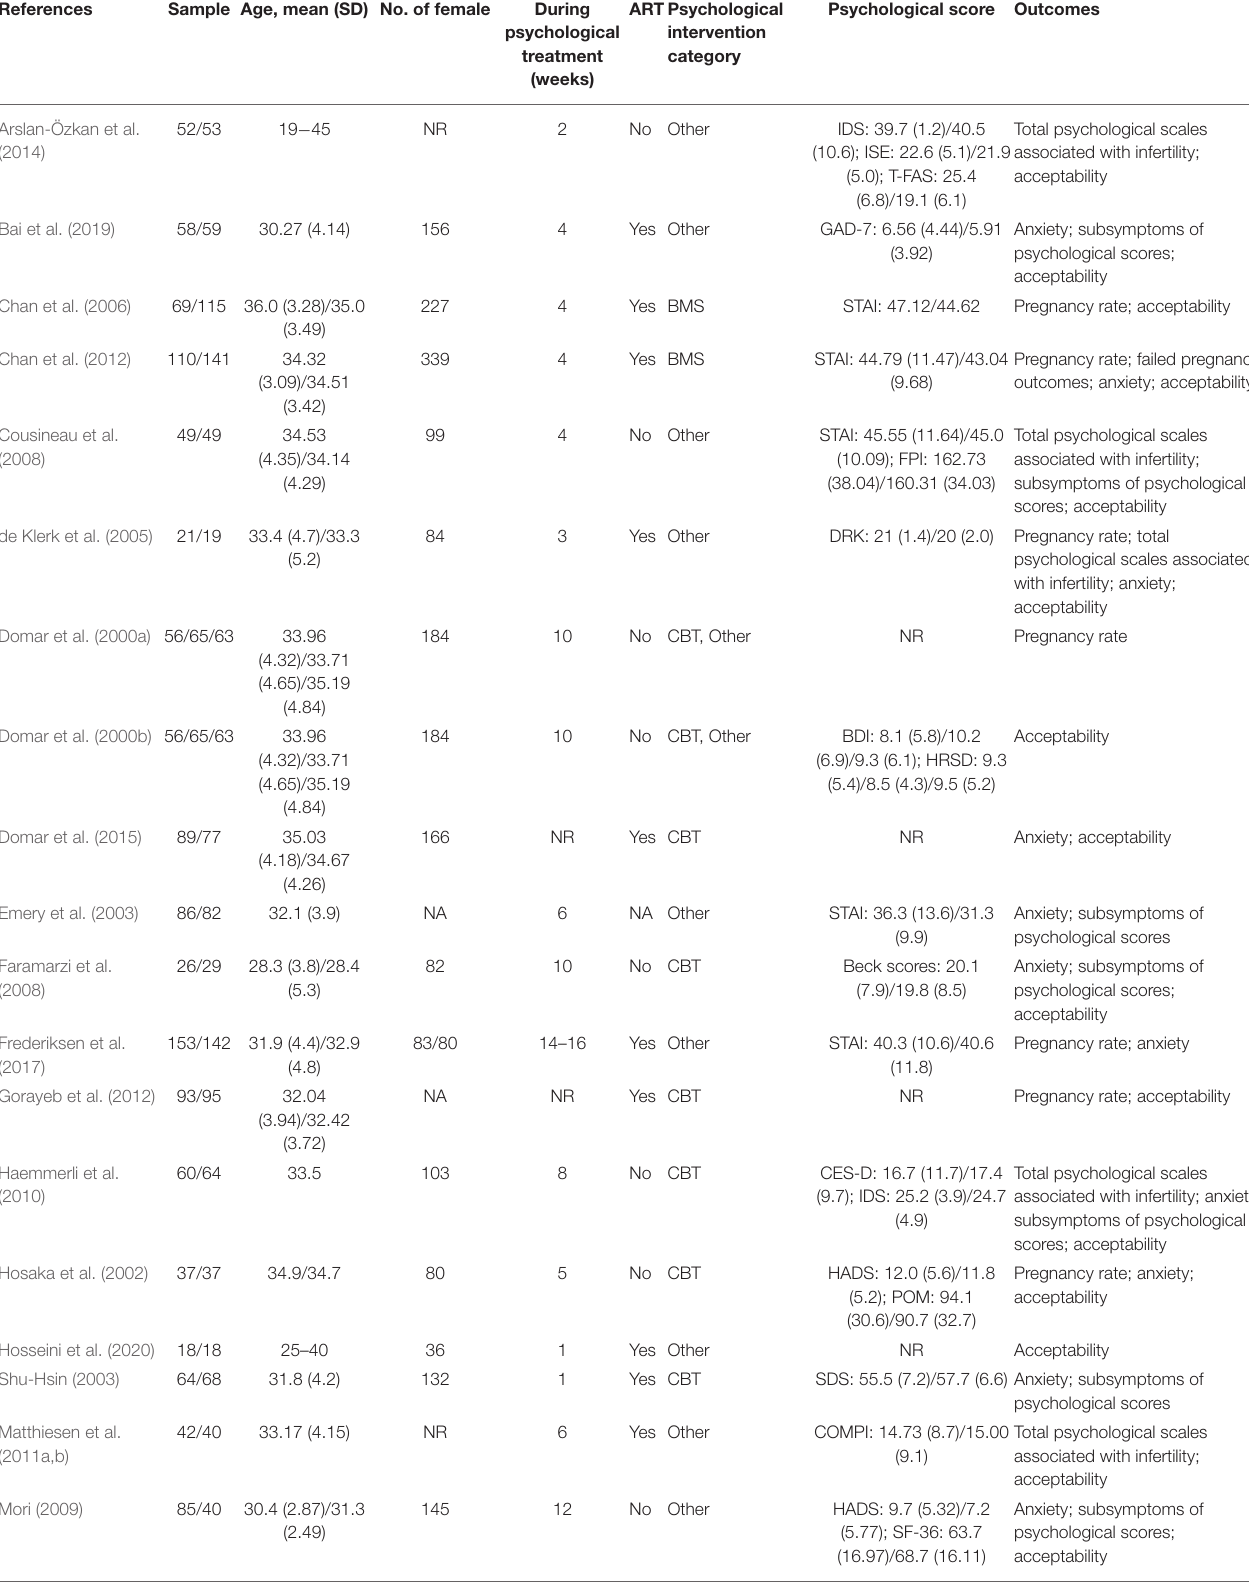
TABLE 1 | Basic characteristics of included